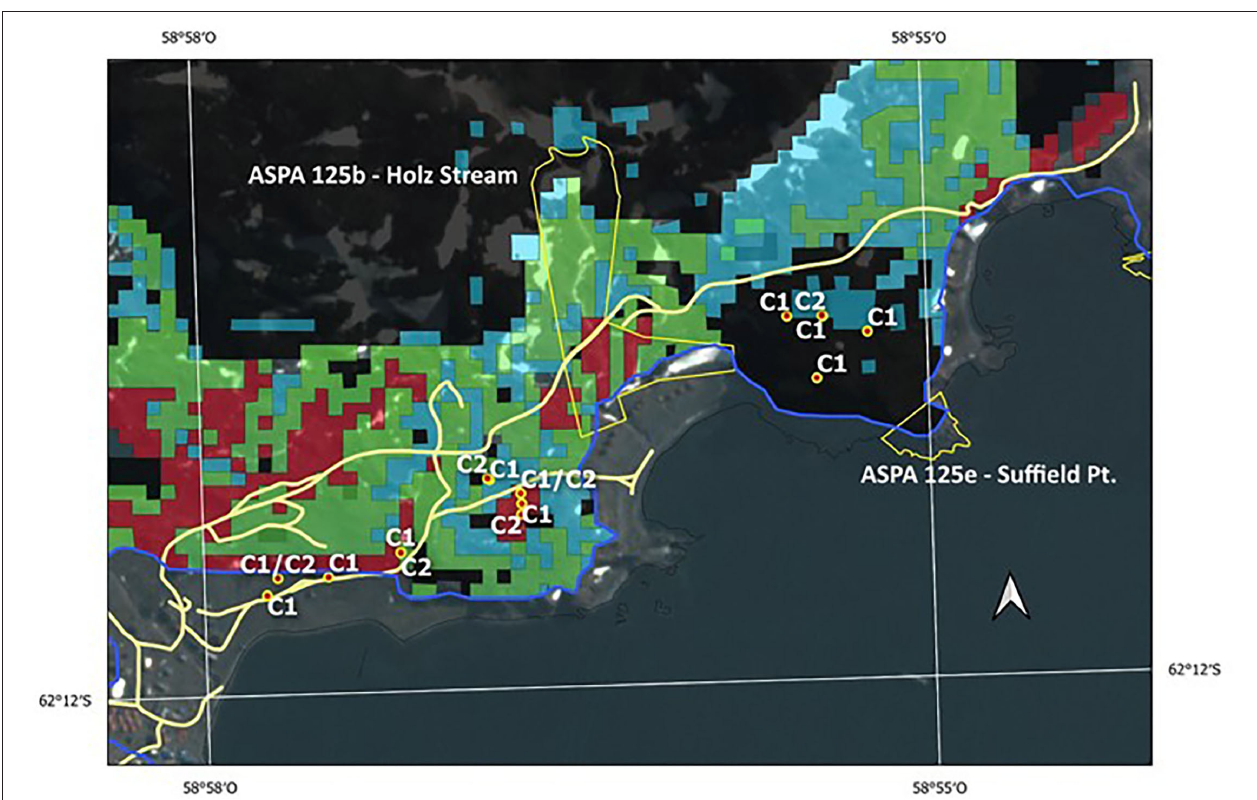
FIGURE 8 | Locations of vulnerable moss sites and current ASPAs 125b—Holz Stream and 125e—Suffield Point boundaries. Red color dots with labels C1 and C2 correspond to Cluster 1 and Cluster 2 samples, respectively. These sites are superimposed over potential distribution probability areas (red color, 71–87%; green color, 61–70%; cyan color, 51–60%, see Figure 7B ) of S. uncinata at 6 ka BP, estimated by model MaxEnt (González et al., 2019). The blue color line is the coastline at 6 ka BP time. Light yellow color lines trace current vehicle